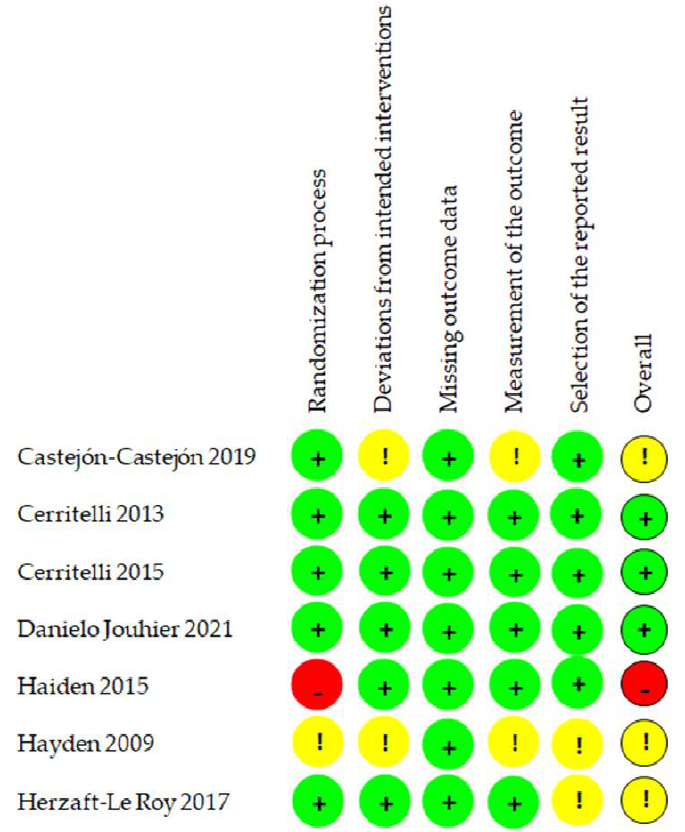
Figure 3. Risk of bias assessment graph of the included studies.